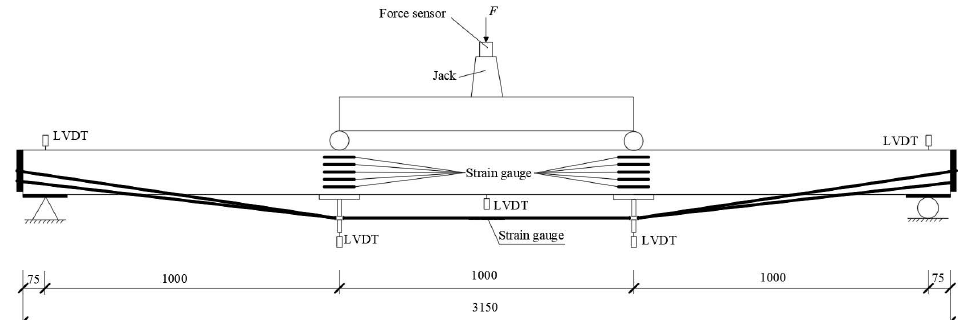
Figure 13. Schematic diagram of the